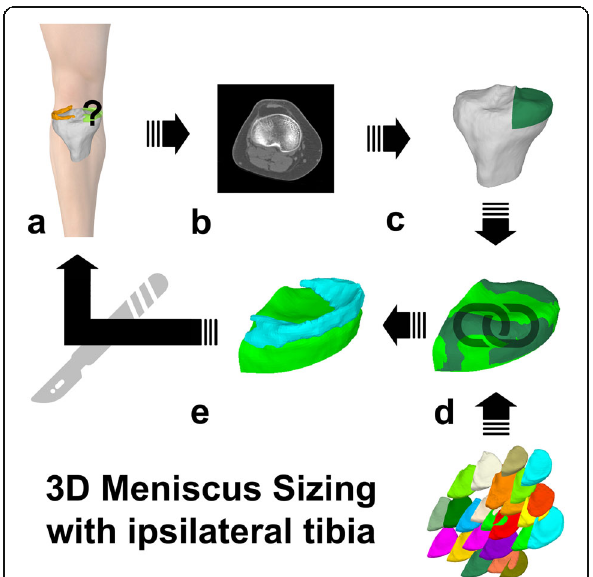
Fig. 3 3D meniscus sizing with ipsilateral tibia plateau. a Right knee with missing medial meniscus . b CT scan of the ipsilateral side . c Tibia plateau segmentation and disc cutting (see also Fig. 4 ) . d Tibia plateau matching with all tibia plateaus of the tissue bank by mean and maximum surface distances (see also Fig. 4 ) . e Selection of best fitting tibia plateau with attached best fitting meniscus for meniscus allograft